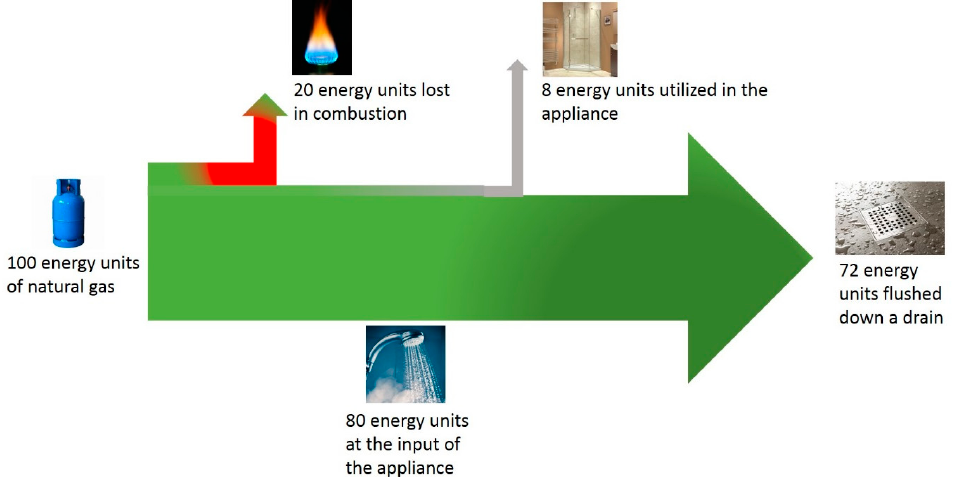
Figure 11. Potential after a sample usage cycle in an appliance.